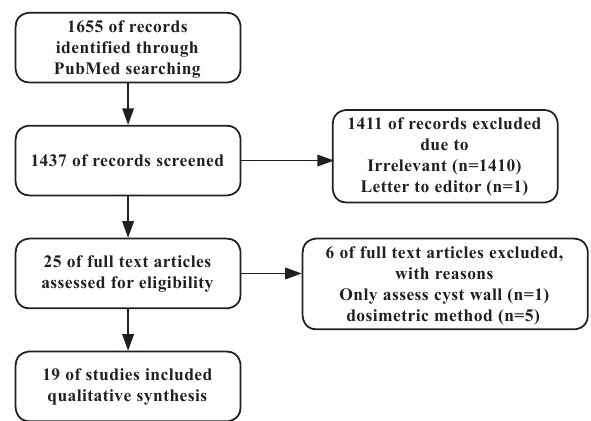
Figure 1 . Relevant manuscript selection